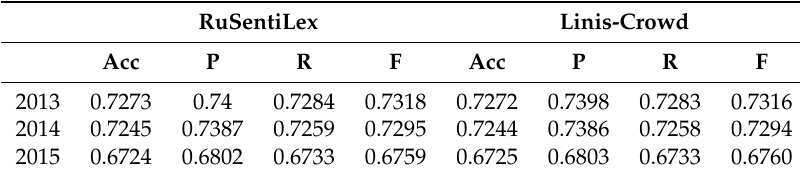
Table 5. Classifier results while activating lexicons RuSentiLex and